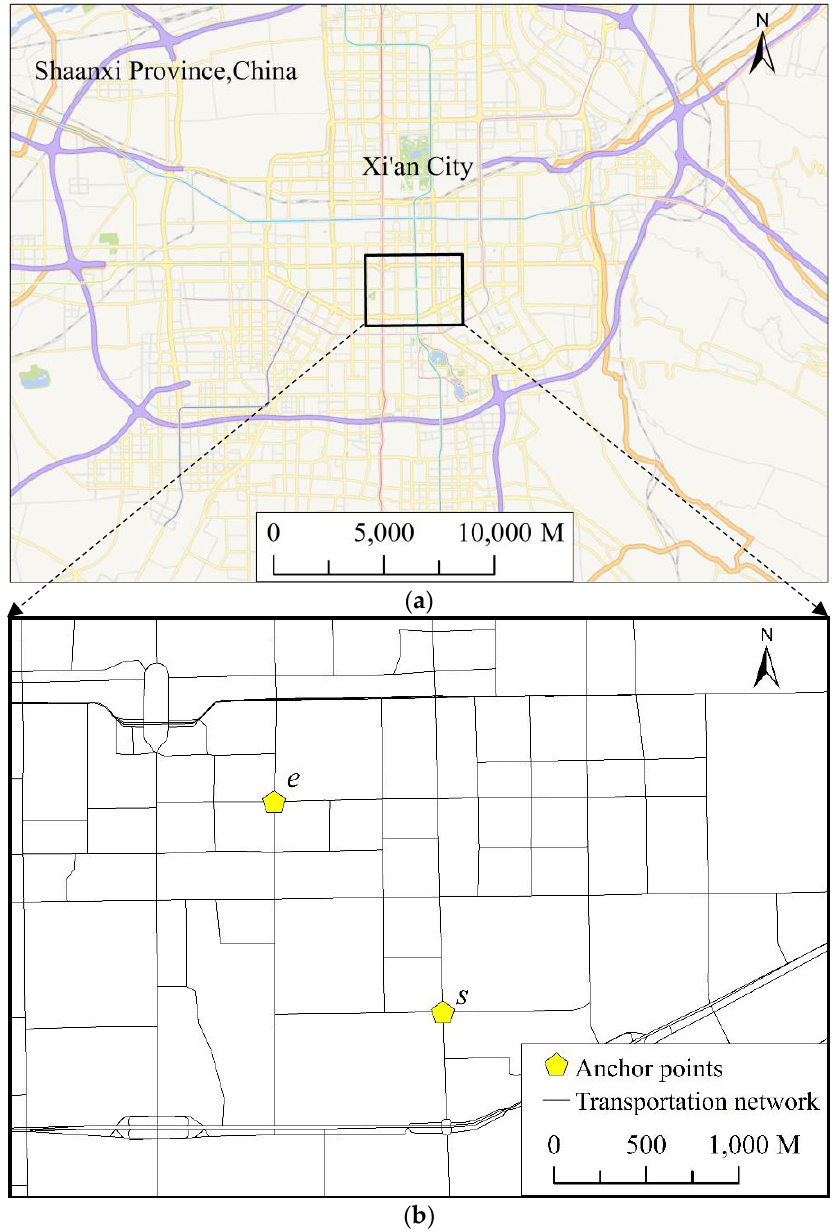
Figure 7. Study area ( a ) and a pair of anchor points in the transportation network ( b ). PNA is constructed for one pair of anchor points ( s (108.960000° E, 34.230000° N), e (108.950000° E, 34.240000° N)) using Equation (1), with a fixed activity time of 0 and a time budget of 1.5 times the minimum cost (Figure 7b). The reason for setting the value to 0 is